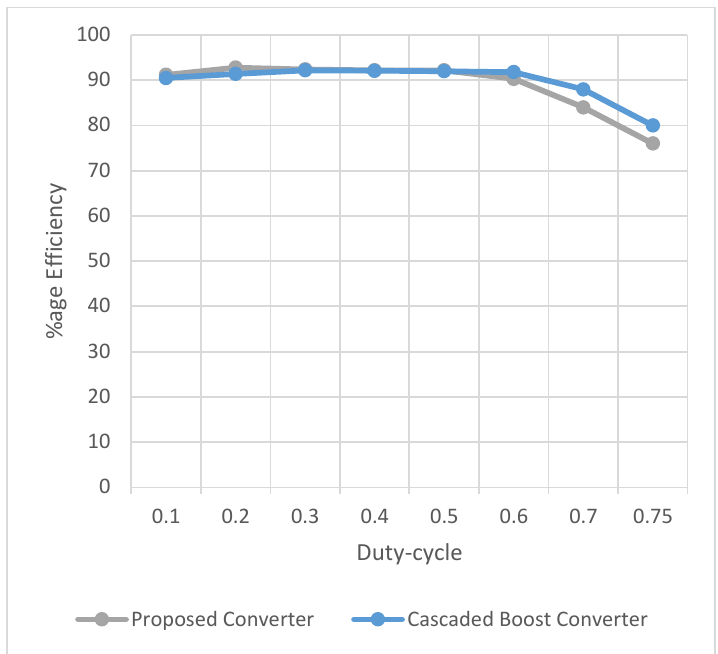
Figure 10. Efficiency comparison of the proposed and a cascaded boost converter.